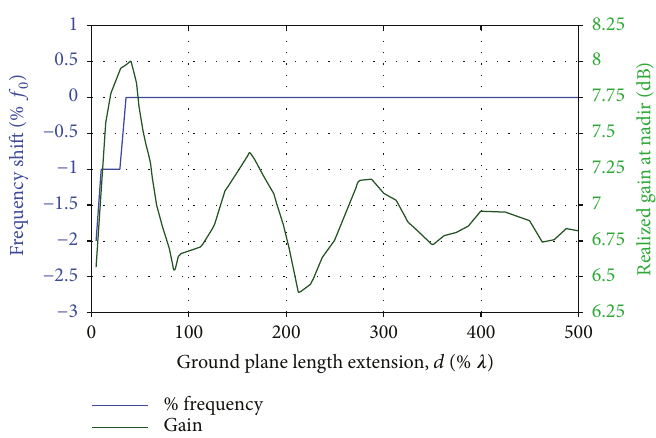
Figure 7: Frequency shift and realized gain for ground plane length extension up to 5 λ at 100MHz.